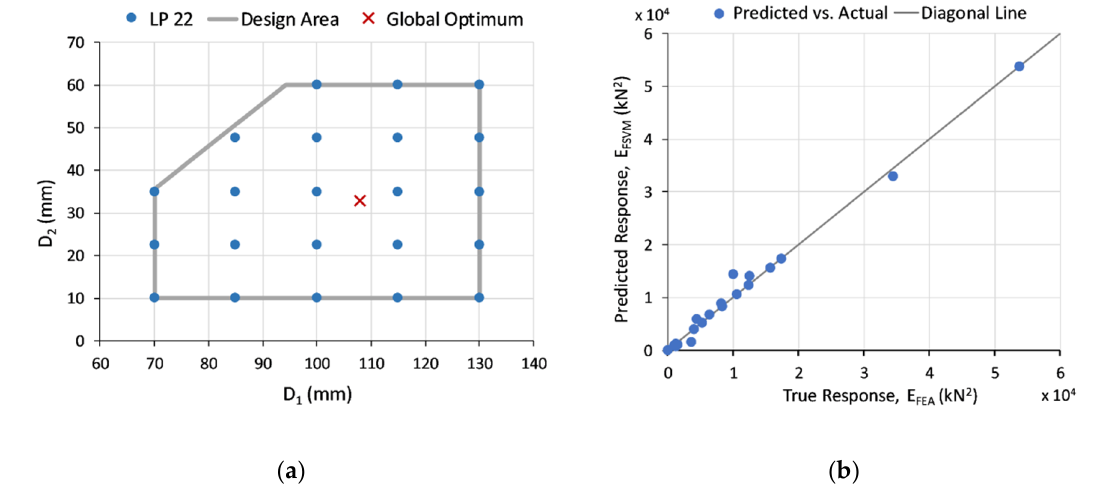
Figure 4. ( a ) The selection of learning points from the design area. ( b ) Comparison of the finite element analysis (FEA) calculated objective function values with the support vector regression (SVR) model calculated predicted responses in the learning points.